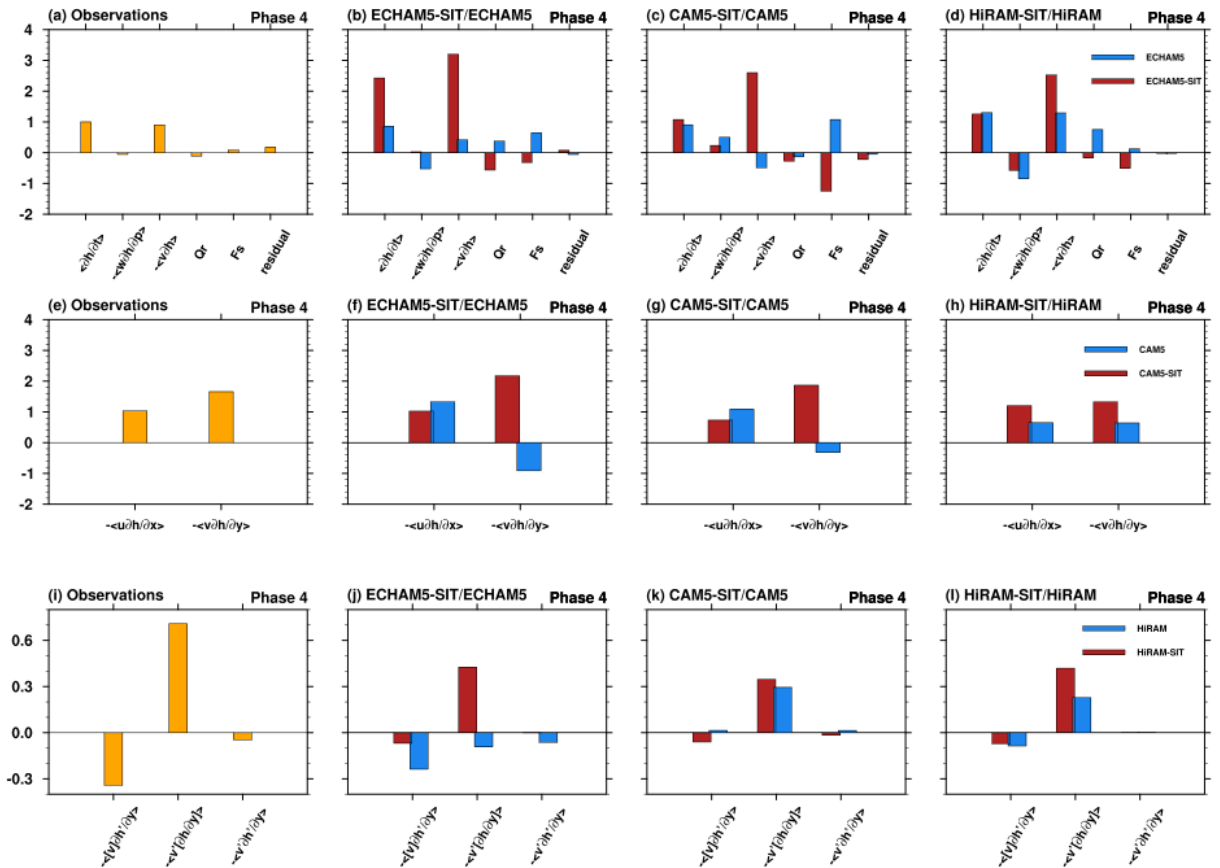
Figure 11. (a–d) The relative role of each MSE component of phase 4 through the projection of the spatial pattern of each MSE budget over the MC (domain) onto the total MSE tendency pattern (Fig. 8a). (e–h) Decomposite of the total horizontal MSE advection based on zonal and meridional components. (i–l) Relative role of the meridional horizontal MSE advection based on the MJO circulation and the mean state of moisture.